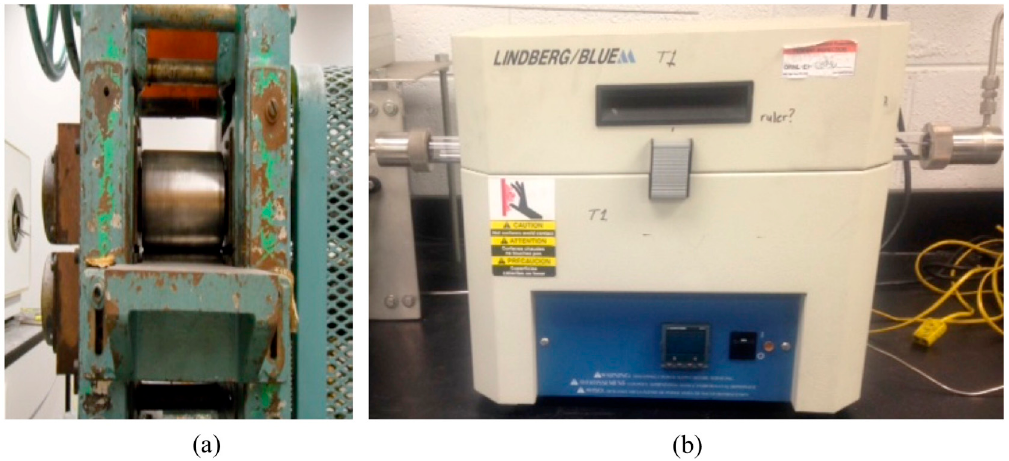
Figure 1. Samples were thermomechanically processed using a ( a ) rolling mill and ( b ) tube